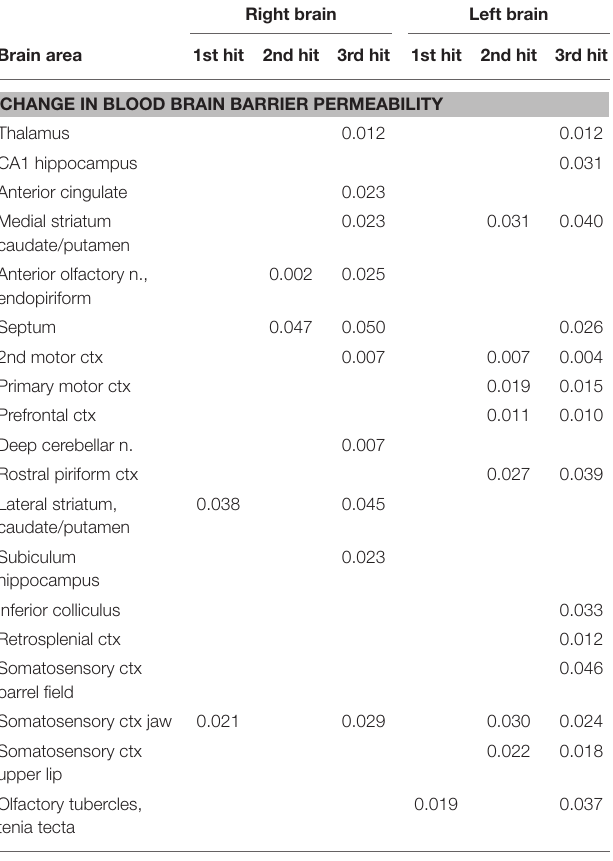
TABLE 1 | Site-specific changes in blood brain barrier permeability with repetitive mild head impacts. Right